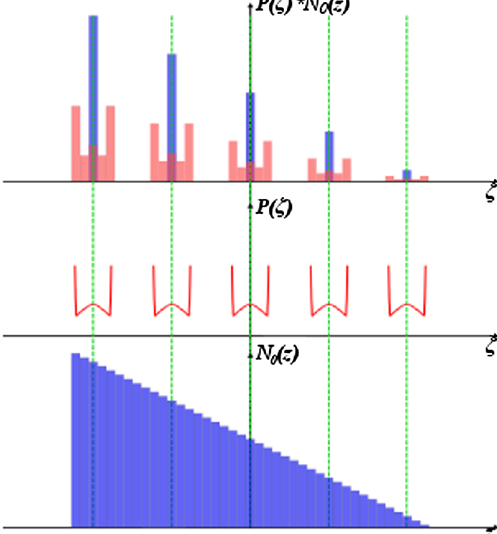
performanceFIG. 17. The SC perturbation. Bottom: The ideal n 0 ð z i f Þ profile. Middle: The perturbation function P ð ζ Þ . Top: Slices of the ideal profile n 0 ð z i f Þ (blue) and the perturbed profile n ð z i f Þ (red). The SC perturbation has a symmetric Gaussian-like spread with spikes at each end, and there is no shift in z i f .